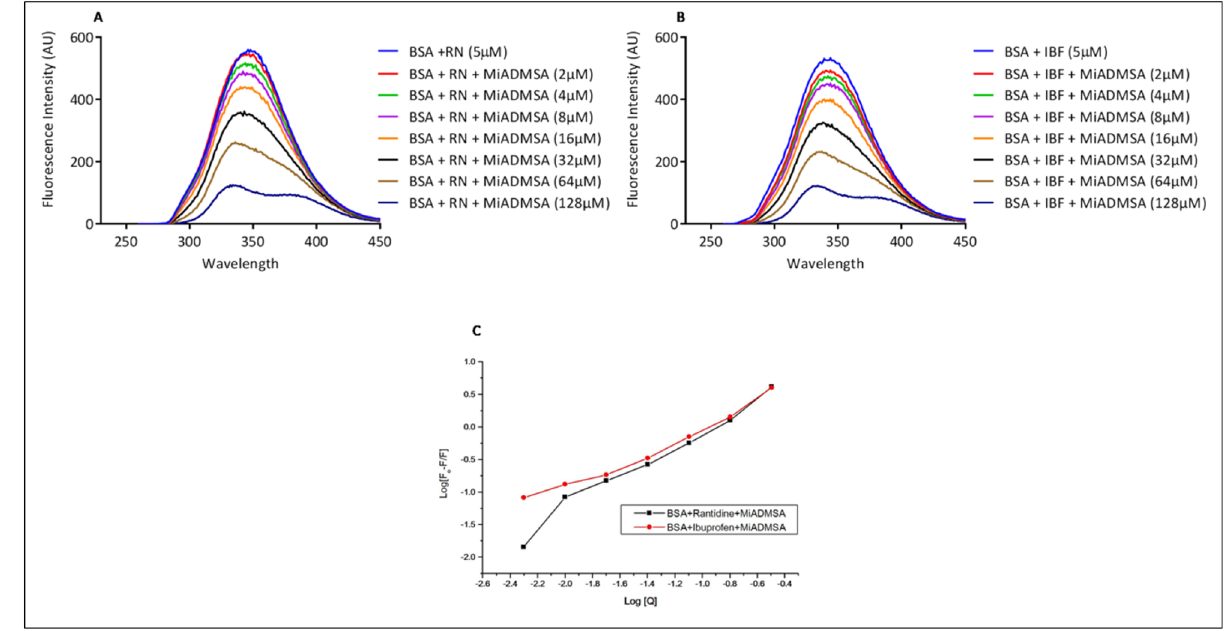
Figure 7. ( A ) Emission spectra of BSA with MiADMSA in presence of site marker Ranitidine; ( B ) Emission spectra of BSA with MiADMSA in presence of site marker Ibuprofen ( C ) Plots of binding constant of BSA with MiADMSA in presence of Ranitidine and